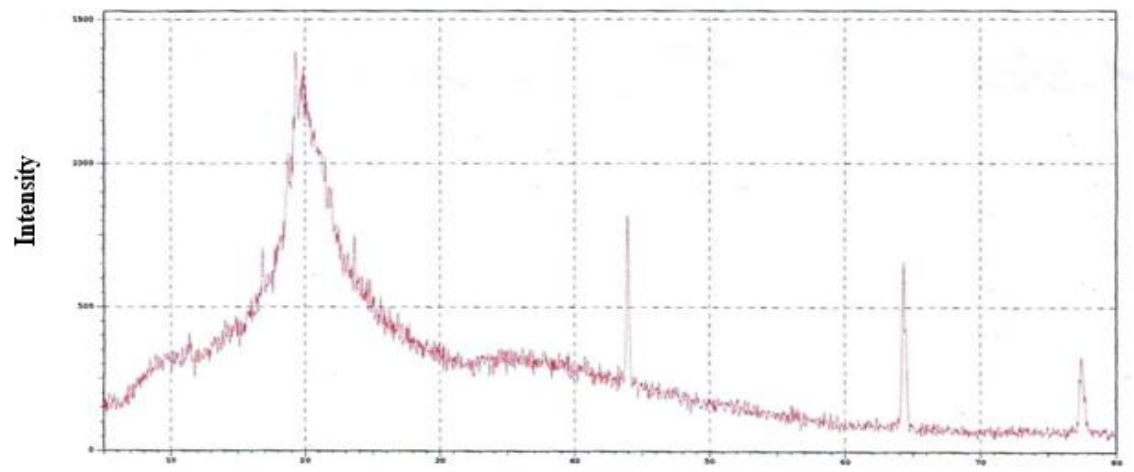
Figure 9. PXRD diffractogram of CCS